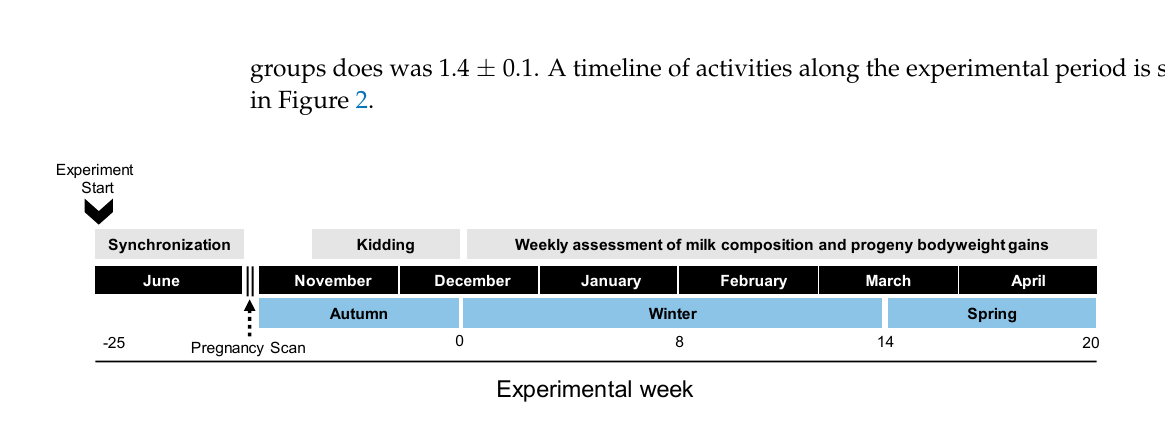
Figure 2. Schematic representation of the main experimental activities performed during the study. Experimental week -25 is when the experiment started and experimental week 20 is when the experiment finished.